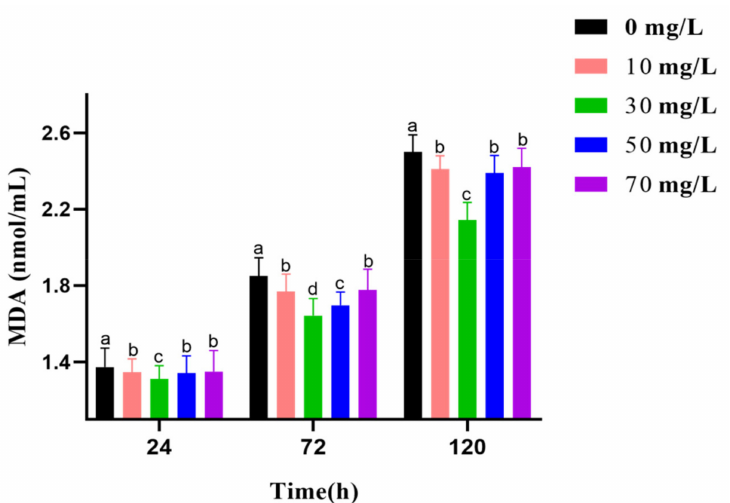
Figure 2. E ff ect of grape seed procyanidin extracts (GSPE) on the MDA level of goat sperm of preserved at 4 ◦ C. Within the same incubation time, values with di ff erent superscripts di ff er among treatments ( p < 0.05). The values are expressed as mean ±